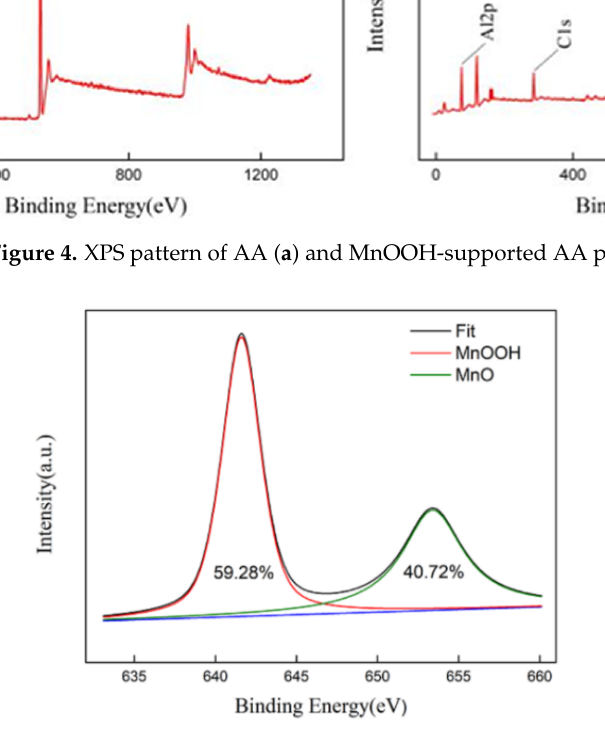
Figure 5. XPS peak-fitting analysis for the Mn2p peak of MnOOH-supported AA.